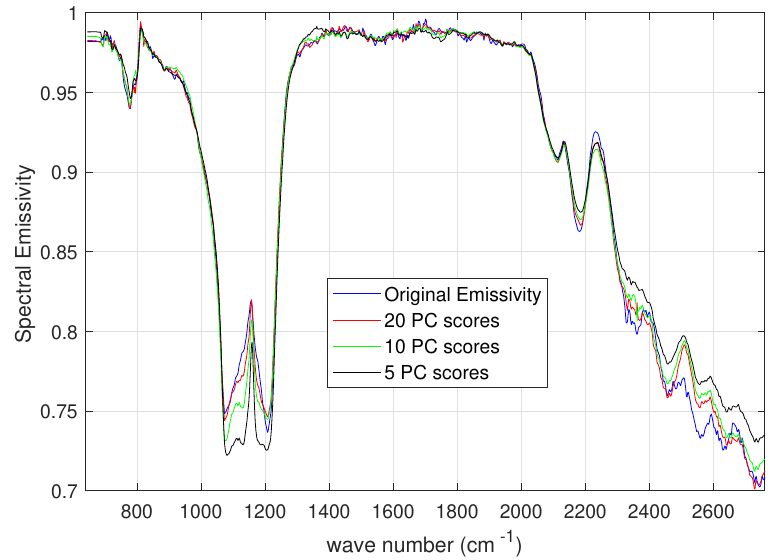
Figure 9. Example of PCA reconstruction of a typical desert sand emissivity with a number of PC scores equal to 5, 10 and 20,